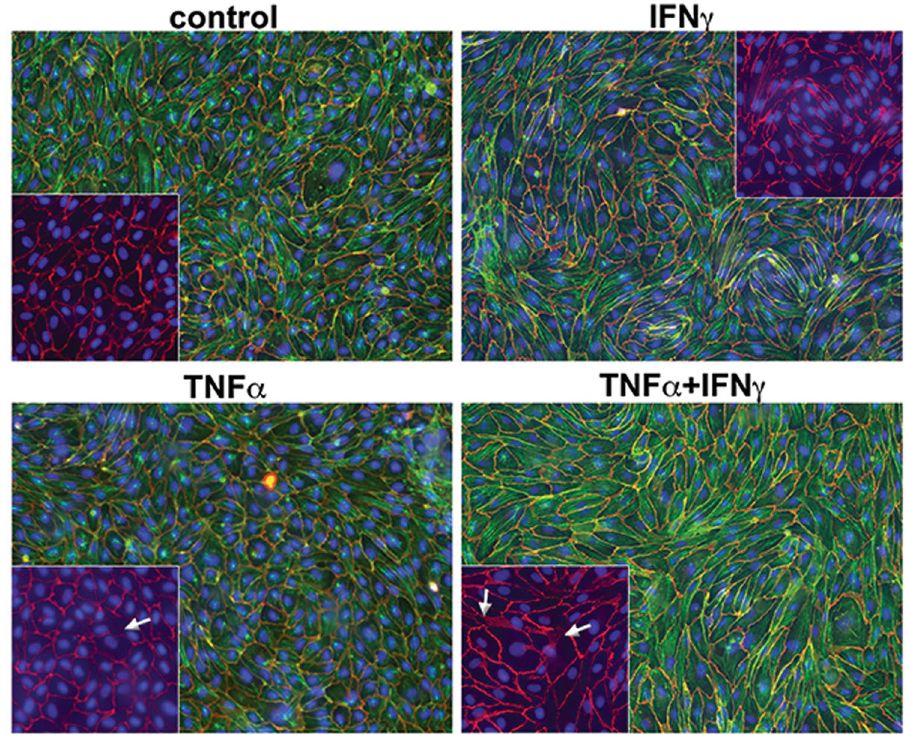
Figure 6. Disruption of cell-cell junction in endothelial cells with IFN- γ and TNF treatment. ( a ) Immuno- fluorescence staining of adherence junction protein VE-cadherin confirms a disruption in HAoEC cell-cell junction upon IFN- γ and TNF- α